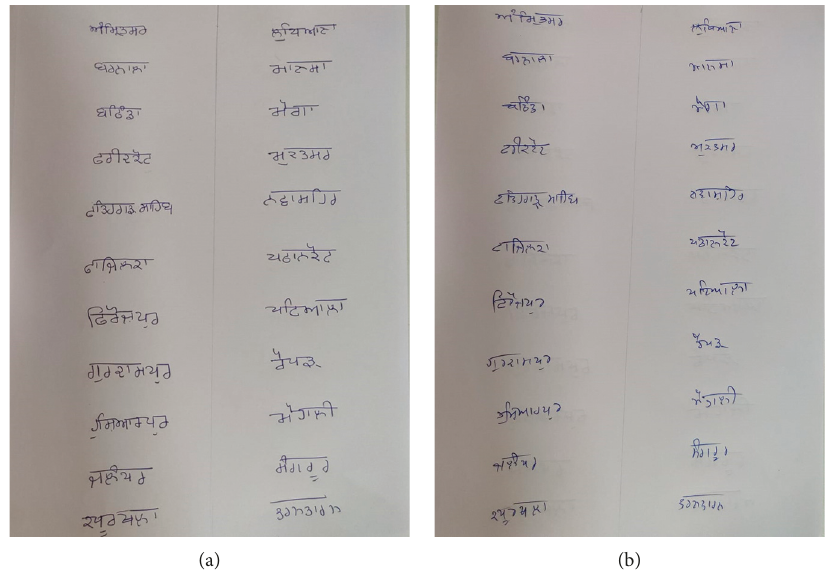
Figure 2: Handwritten sheets: (a) written by “Writer 1” and (b) written by“Writer 2.”